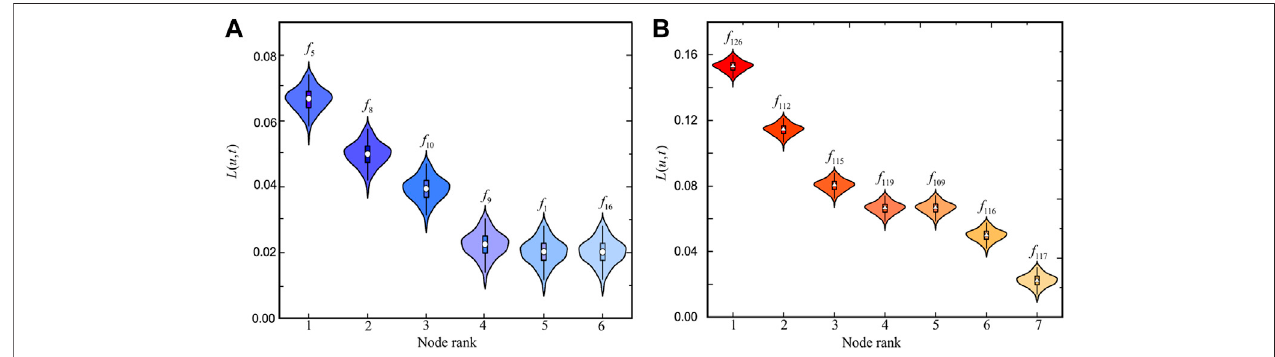
FIGURE 5 | Violin plots presenting the maximum likelihood L ( u , t ) for all possible infection sources with (A) infected pig farm node f 20 and (B) infected slaughterhouse node h 6 .